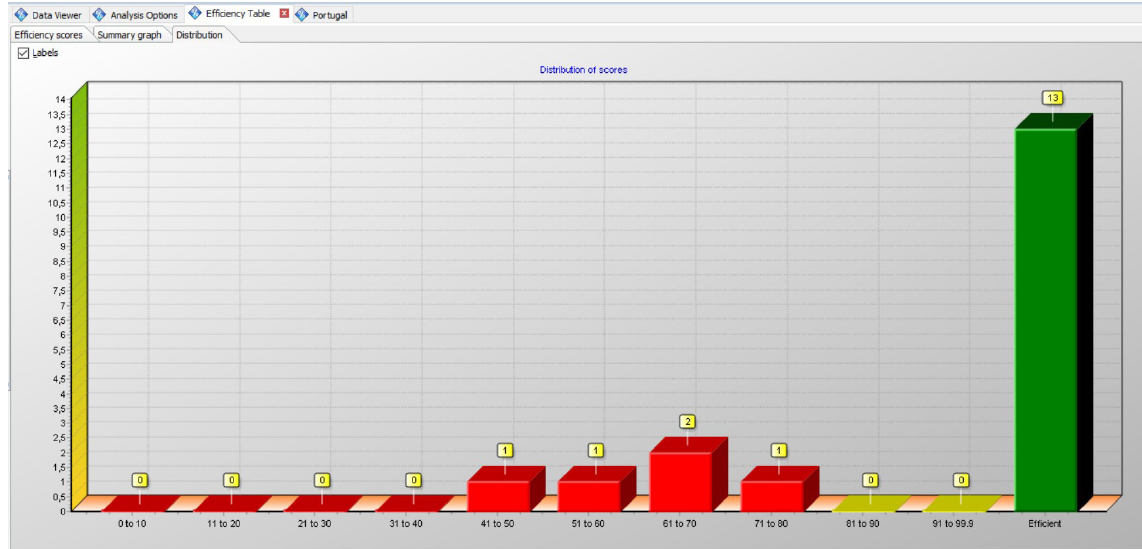
Figure 5. Distribution graph of assessing the efficiency of banking systems of 17 European countries and Ukraine as of 2020 for the DEA BCC model